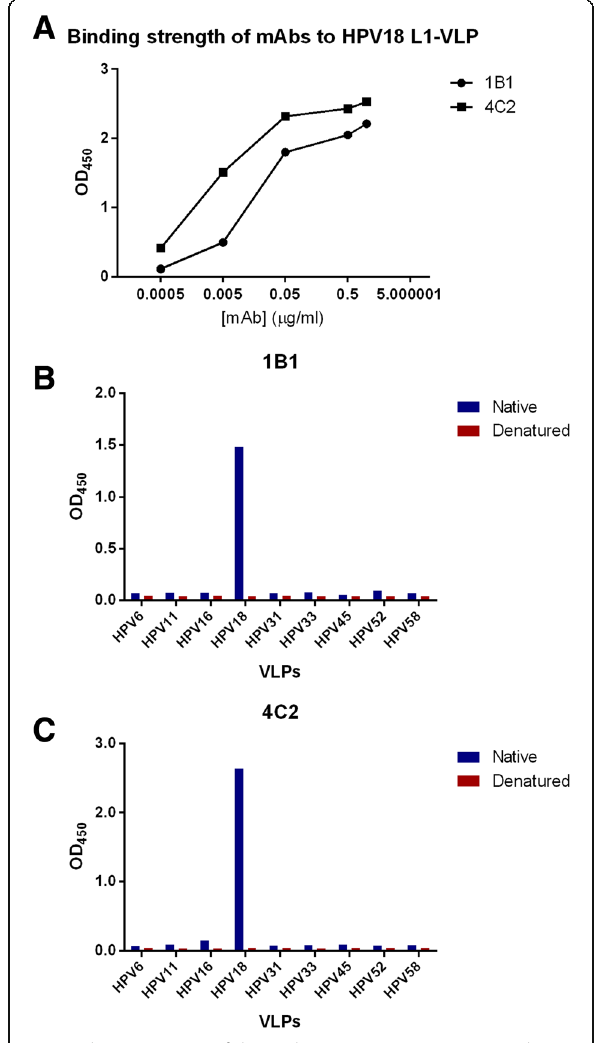
Fig. 2 Characterization of the mAbs against HPV18 L1-VLP. a The binding strength of mAbs 1B1 and 4C2 to HPV18 L1-VLPs. OD 450 is the optical density at 450 nm; the concentrations of the mAbs are given in μ g/ml. The reaction curves were sharply increased at the turning point of 0.05 μ g/ml. The results indicate that both 1B1 and 4C2 mAbs have similar binding capabilities to HPV18 L1-VLPs; b and c Specificities of mAbs 1B1 and 4C2 to native or denatured HPV L1- VLPs. The optical density at 450 nm (OD 450 ) of mAbs 1B1, 4C2 mAbs were plotted on the y-axis against various genotypes of native or denatured VLPs on the x-axis. The bar graph was prepared using Prism GraphPad 6.0. All mAb samples were adjusted to an initial concentration of 0.3 μ g/ml. All values are the average of multiple Table 2 Binding affinity of mAbs 1B1 and holes. L is the native protein, and D is the denatured protein (Table 1). The IC of 1B1 and 4C2 were 0.039 μ g/ml 50 and 10.00 μ g/ml respectively; and the IC of each mAbs 90 were 0.156 μ g/ml and 40.140 μ g/ml respectively. These data demonstrated that both mAbs had a certain degree of inhibition reactions, and thus neutralization activities. The lower the IC , the higher the neutralizing activity 50 towards HPV18 L1-VLPs the mAb had.